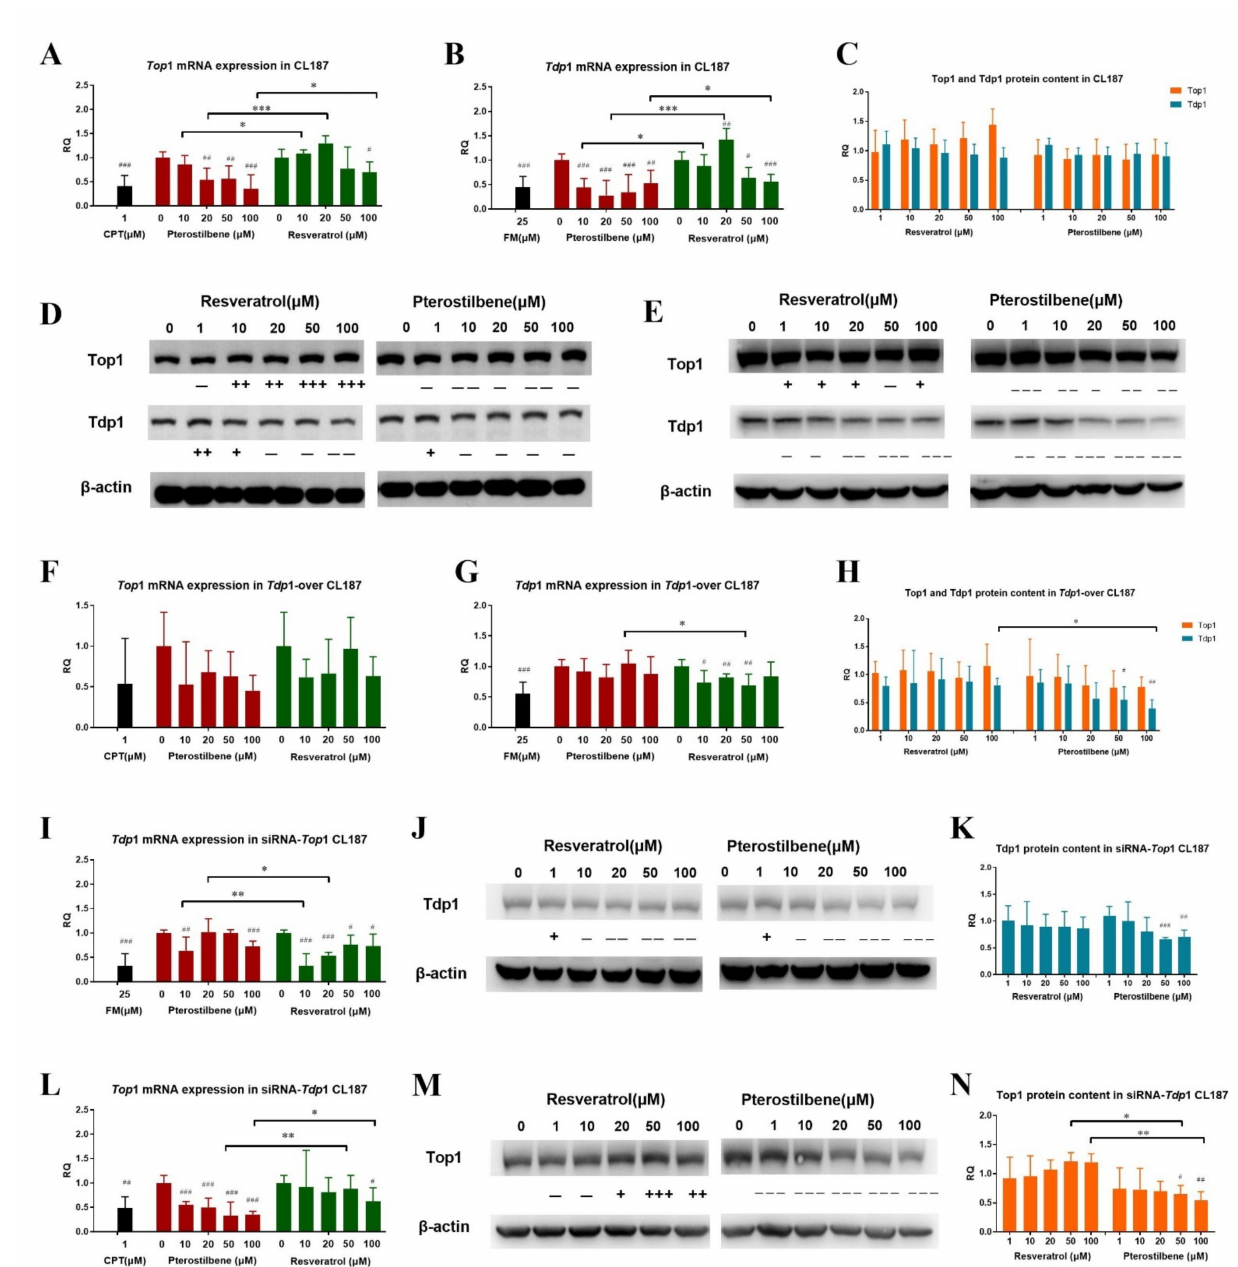
Figure 7. Effects of PTE and RE on intracellular Top1 and Tdp1 protein contents and mRNA expression after drug incubation for 6 h. The mRNA expression levels of Top 1 and Tdp 1 in CL187 cells ( A , B,C ). WB probing ( D ) and relative gray value analysis of WB results I for the protein content of Top1 and Tdp1 in CL187 cells. The mRNA expression levels of Top 1 and Tdp 1 in Tdp 1-over CL187 cells ( F , G ). WB probiI( E ) and relative gray value analysis of WB results ( H ) for the protein content of Top1 and Tdp1 in Tdp 1-over CL187 cells. Tdp 1 mRNA expression ( I ), WB probing ( J ) and relative gray value analysis of WB results ( K ) for the protein content of Tdp1 in siRNA- Top 1 CL187 cells. Top 1 mRNA expression ( L ), WB probing ( M ) and relative gray value analysis of WB results ( N ) for the protein content of Top1 in siRNA- Tdp 1 CL187 cells. Loading was normalized based on the level of the internal control, β -actin. Compared with the control group, “+” or “ − ” was denoted when the change of gray value was between 0 and 10%, “++” or “ − − ” was denoted when the change of gray value was between 10–20%, “+++” or “ − − − ” was denoted when the change of gray value exceeded 20%. * p < 0.05, ** p < 0.01, and *** p < 0.001 vs. the RE treatment group. # p < 0.05, ## p < 0.01 and ### p < 0.001 vs. control group. ns, not significant. Data are mean ± SD, n =